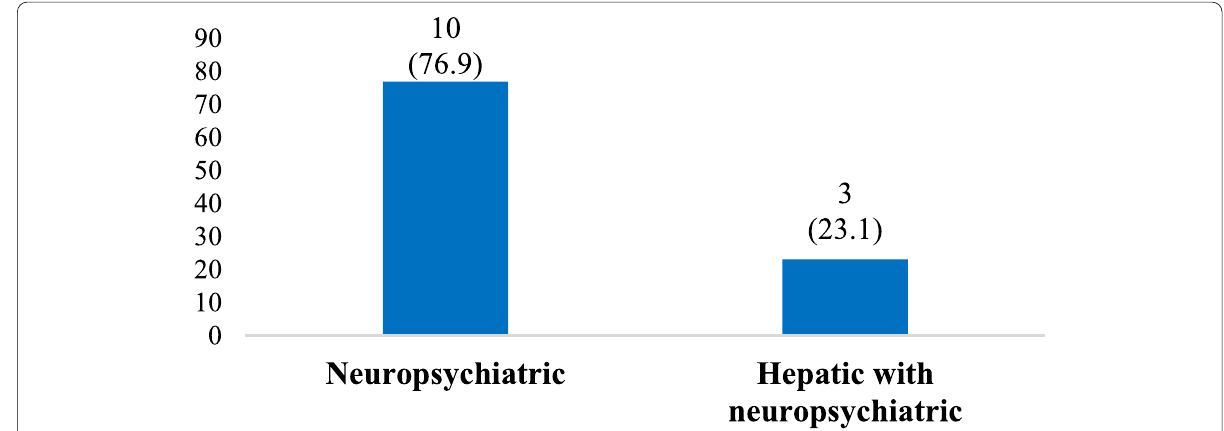
Fig. 3 Different types of neuropsychiatric presentation in the studied children ( n